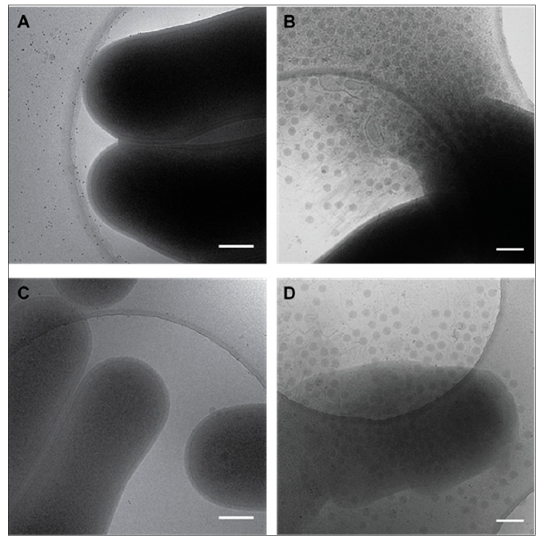
Figure 4. Cryo-EM images of M. smegmatis infected with Ms6 wt or Ms6 Δ lysB . At 90 min post-adsorption, cells infected with Ms6 wt ( A ) or Ms6 Δ lysB ( C ) are still intact and no difference is observed. At 150 min post-adsorption, the abrupt burst of a cell infected with Ms6 wt is clear ( B ) while cells infected with Ms6 Δ lysB ( D ) do not lyse abruptly and deformations in the cell envelope are clearly visible. Scale bar (200 nm).